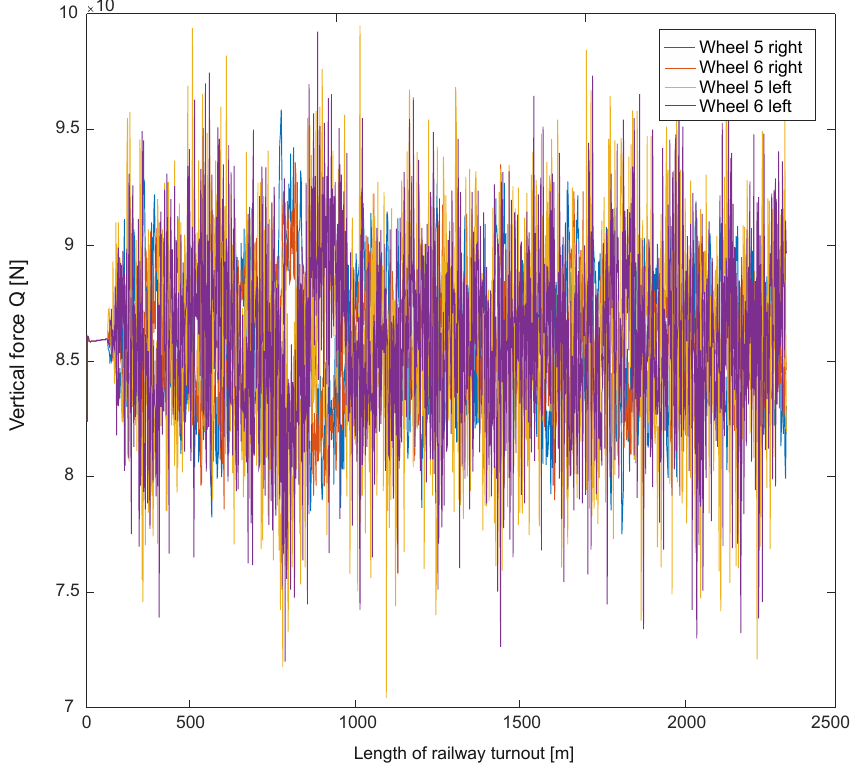
Figure 19 . Vertical force at 200 km/h on a straight track without a turnout.